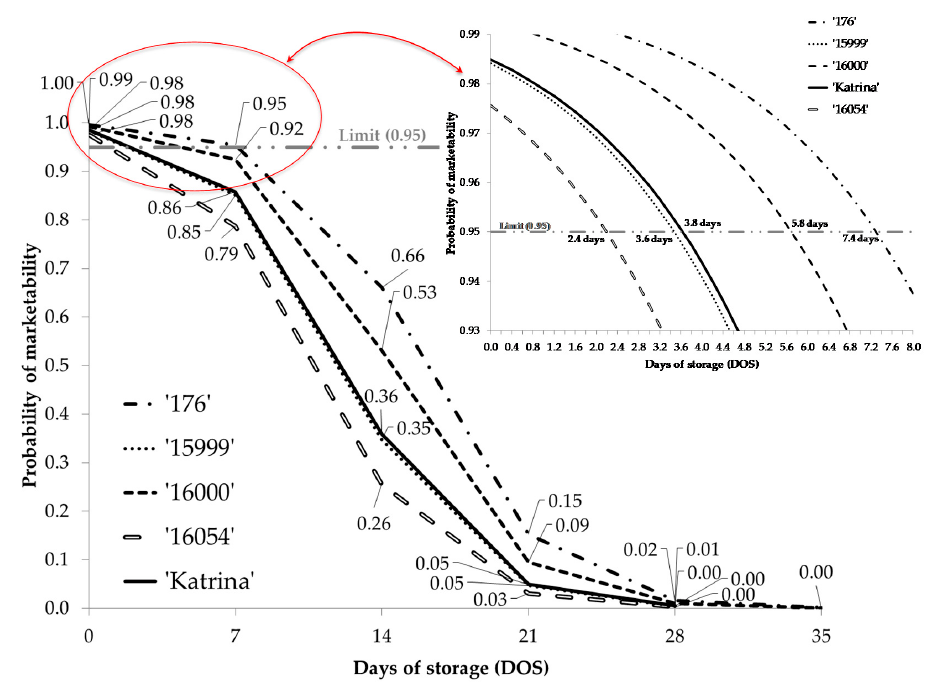
Figure 7. Timeline of the probability of marketability as a function of the days of storage (DOS) for the mini-type cucumber cultivars.